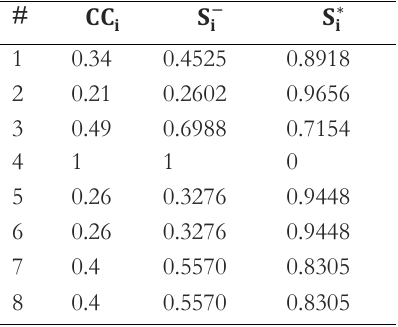
Table 6. Calculating closeness to ideal and non-ideal solutions and similarity